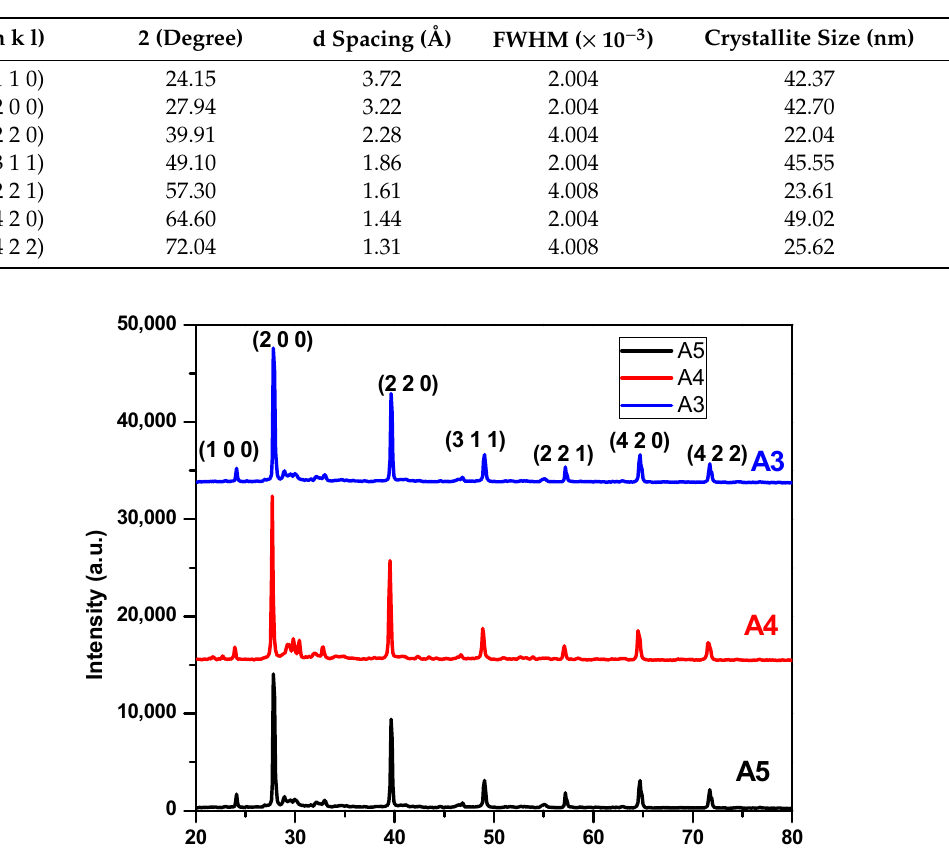
Figure 6. X-ray di ff raction (XRD) analysis of samples A3, A4, and Figure 6. X-ray diffraction ( XRD) analysis of samples A3, A4, and A5.